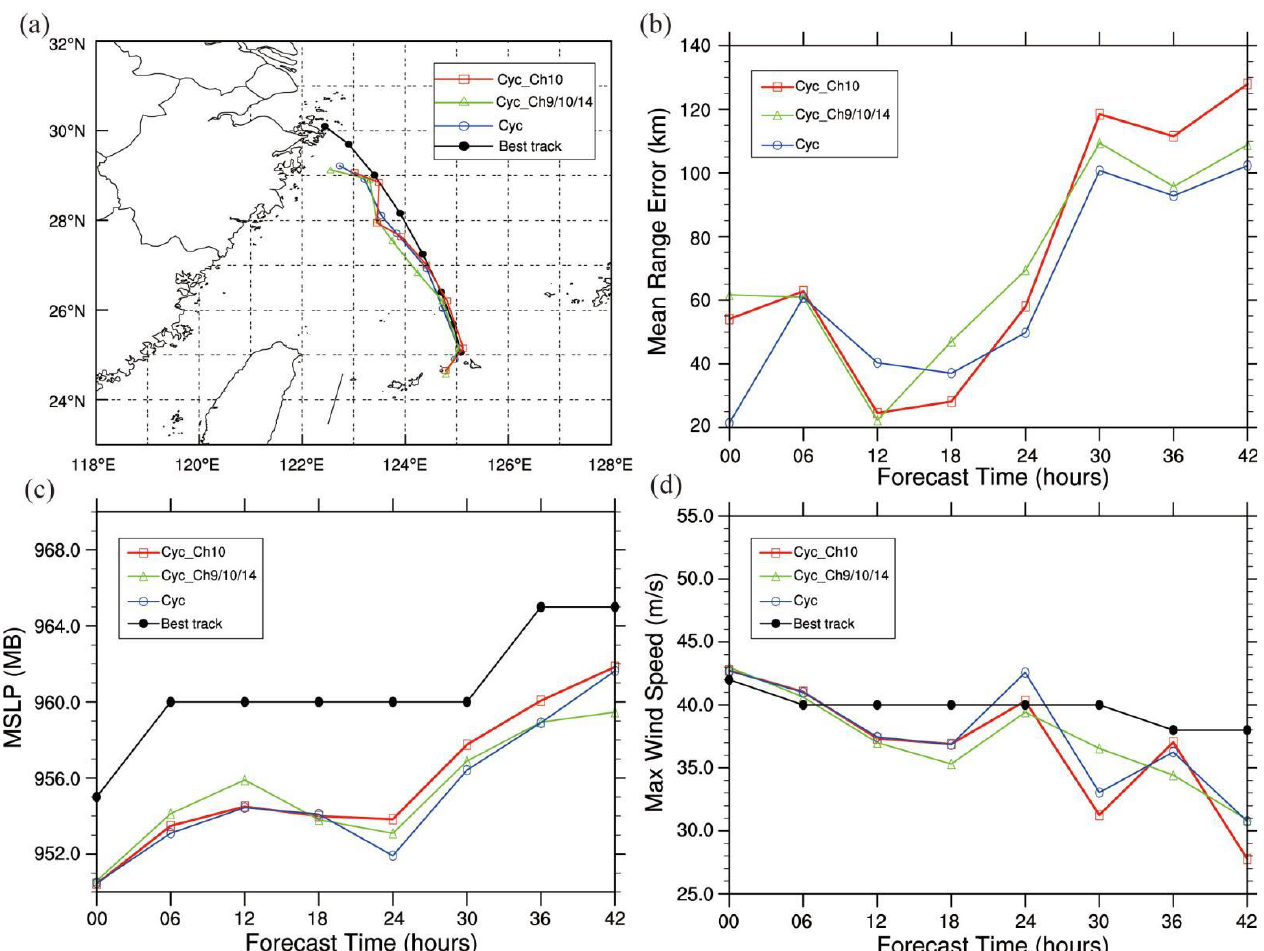
Figure 4. The predicted ( a ) tracks, ( b ) track errors, ( c ) minimum surface level pressure (hPa), and ( d ) max wind speed (m/s) in the Cyc (blue lines), Cyc_Ch9/10/14 (green lines), and Cyc_Ch10 (red lines) experiments are compared to the CMA best-track estimates (black lines) from 1200 UTC 23 July 2021 to 0600 UTC 25 July 2021.